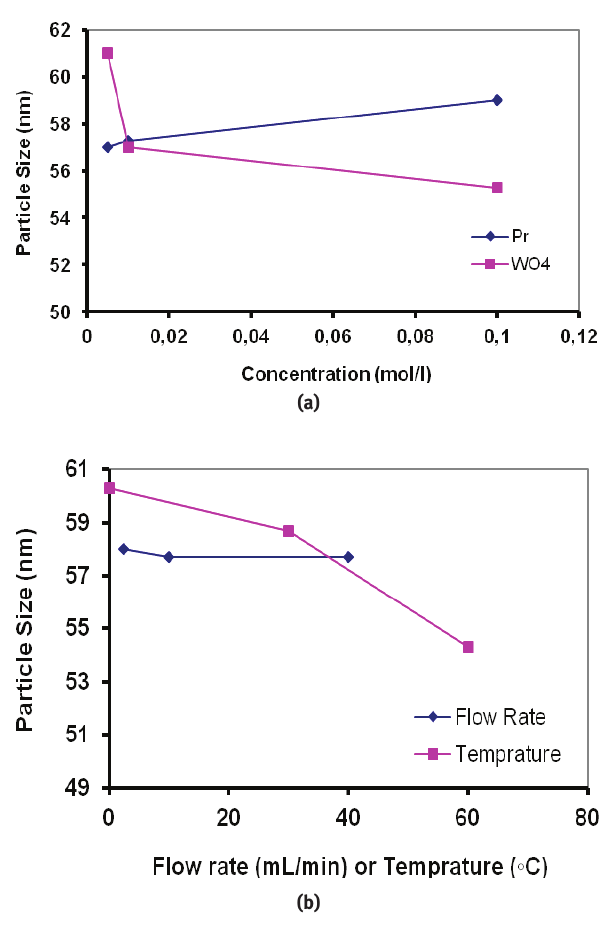
(WO ) corresponding to the 2 4 3